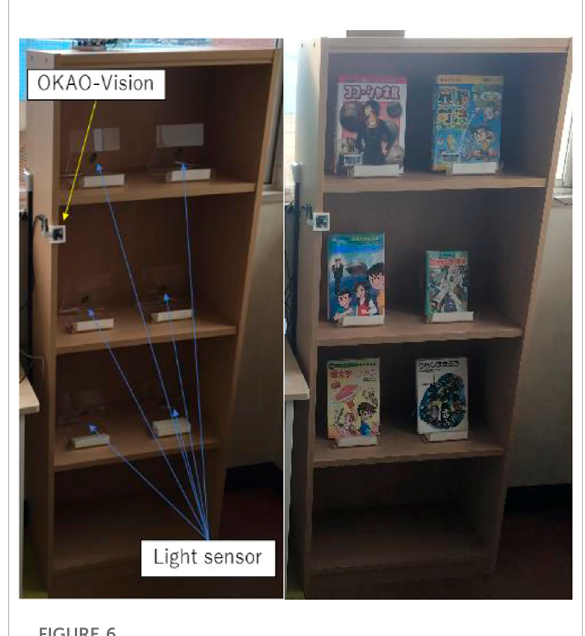
FIGURE 6 Bookshelfwithsensorsinstalled,asshownontheleft:OKAO- VISION detects the location of the face, and the light sensor detects the presence of the book. The right side shows the situation where the book is